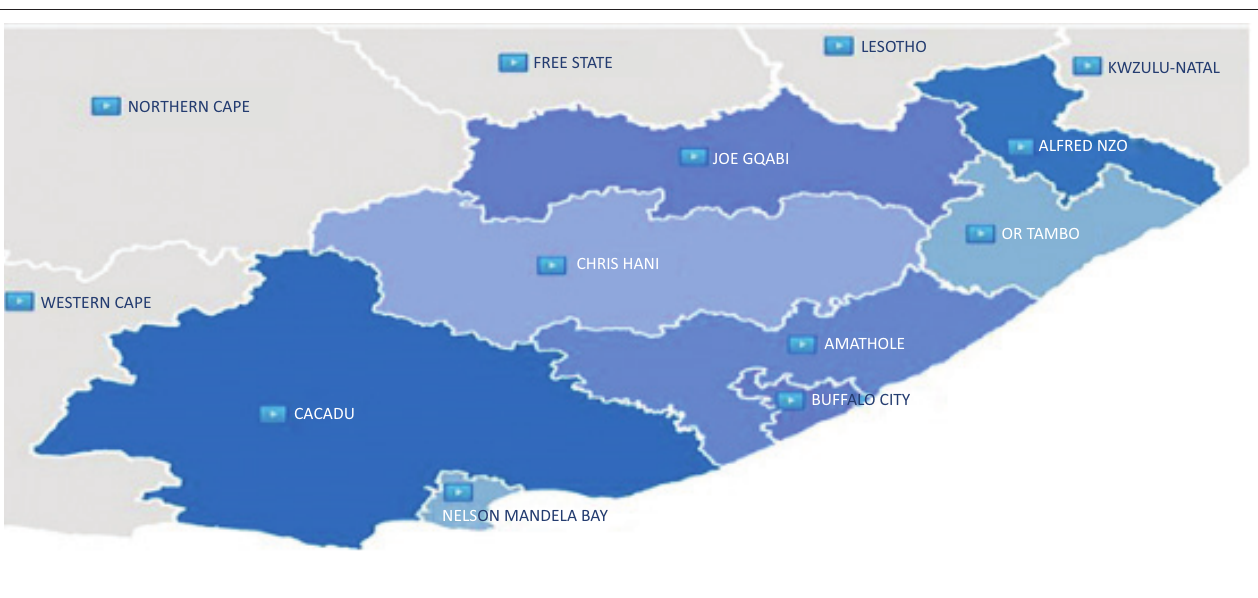
FIGURE 1: Eastern Cape